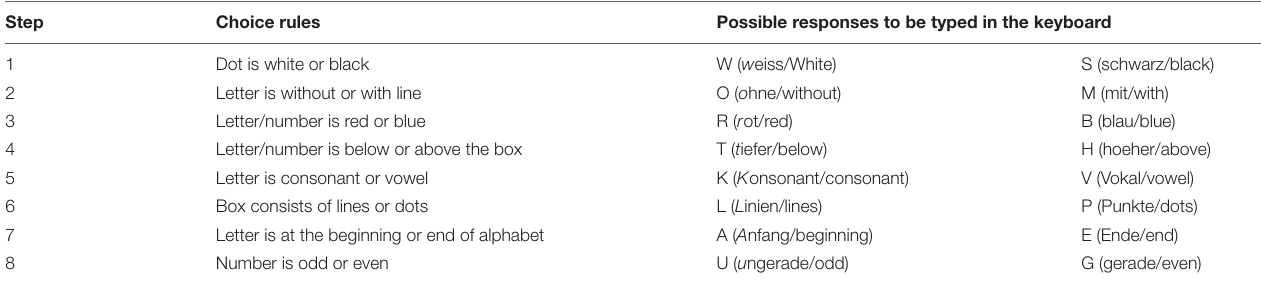
TABLE 1 | List of steps, choice rules, and possible answers in WORTKLAU task translated from German to English. Possible answers that form the acronym are provided in both German (direct link to the acronym by first letter of one of the alternatives) and English. Step Choice